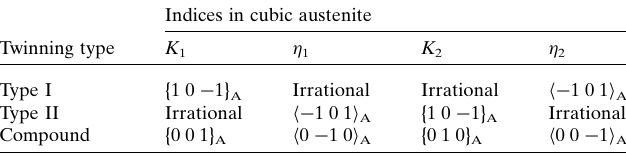
Table 3 Solutions of the twinning equation for the three types of twin in the present work.